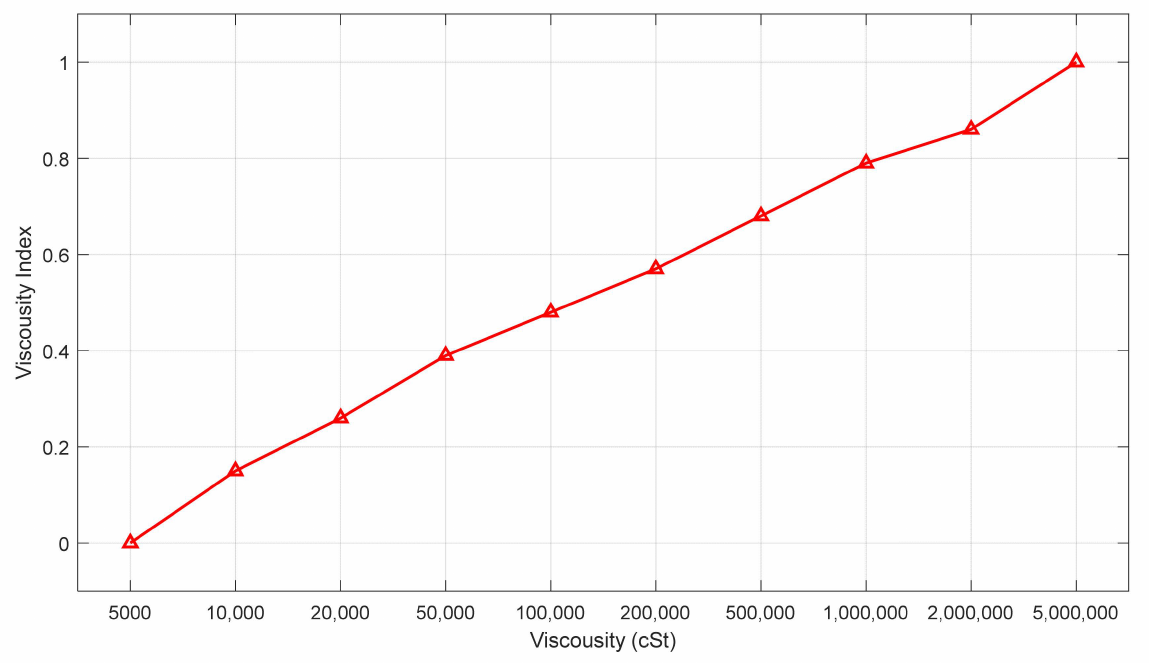
Figure 14. Viscosity index of different viscosity damping fluids.